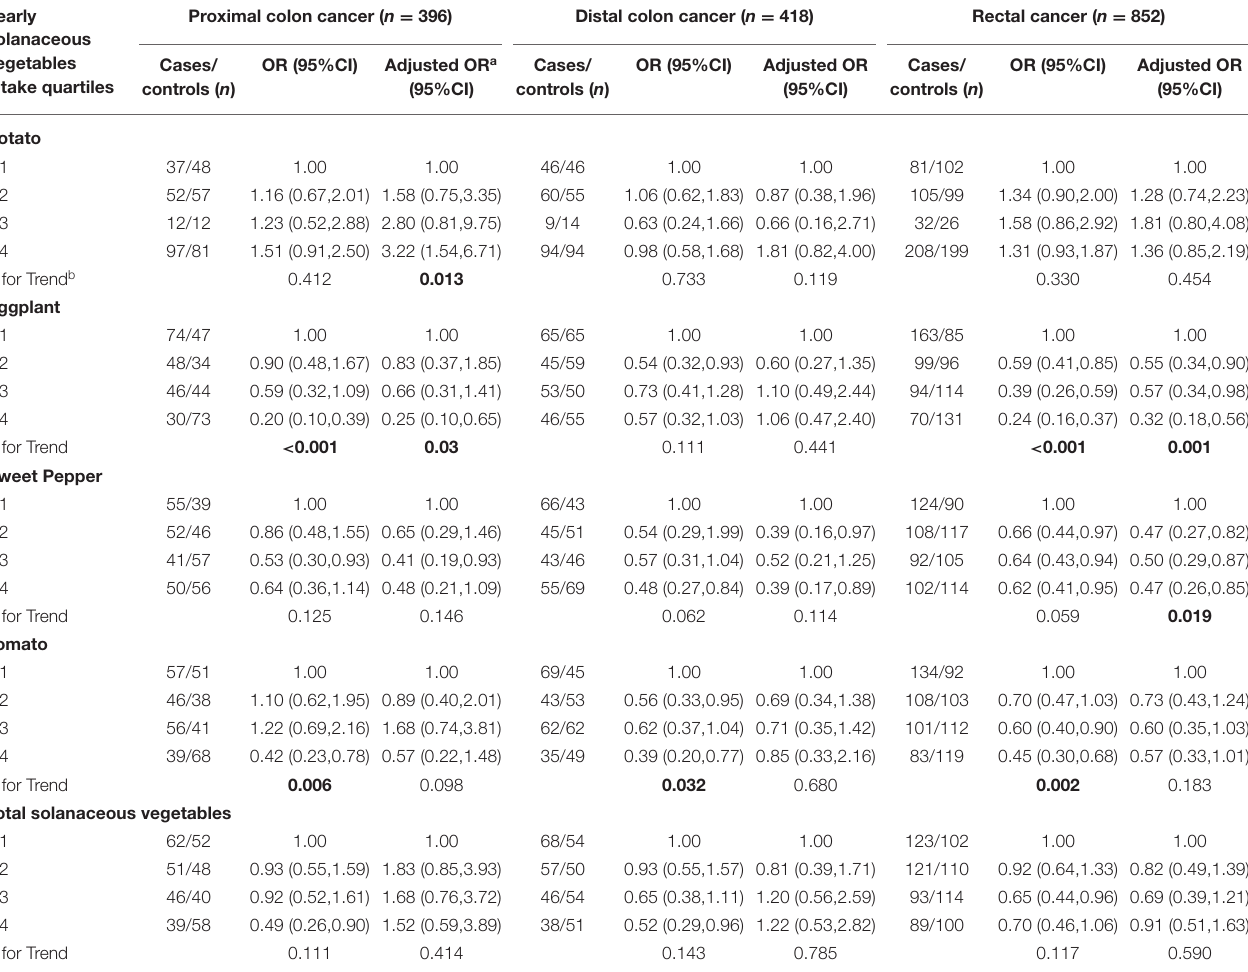
TABLE 4 | Odds ratios (ORs) and 95% confidence intervals (CIs) for the association of yearly solanaceous vegetables intake and colorectal cancer risk according to subsite. Yearly solanaceous vegetables intake